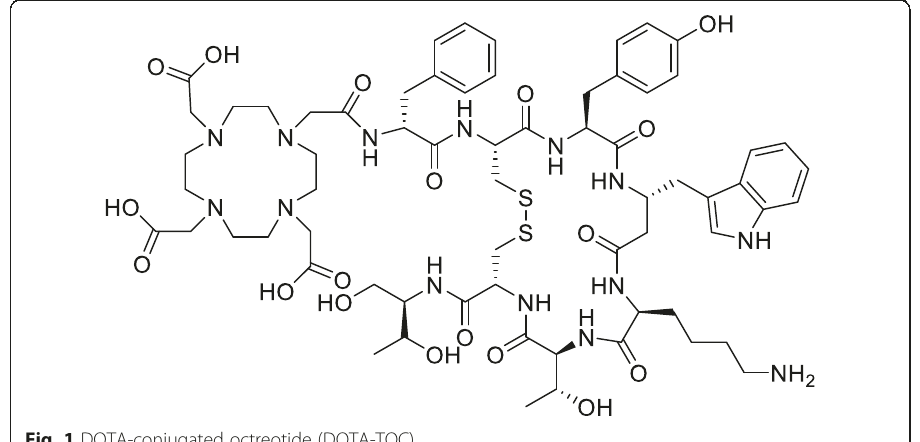
Fig. 1 DOTA-conjugated octreotide